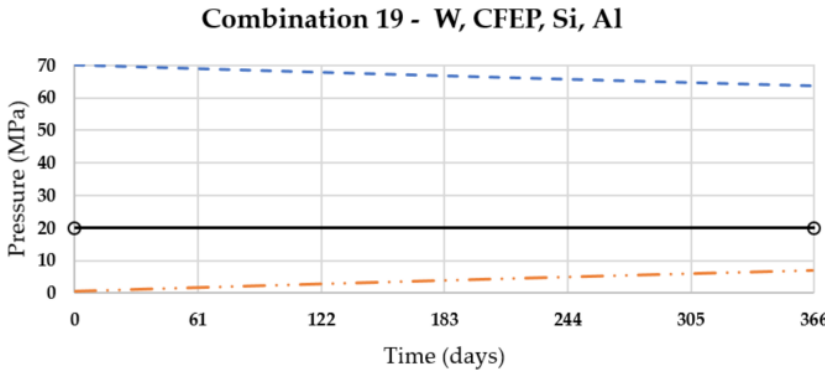
Figure 4. Pressure inside of the spheres and the envelope tank, combination 7 from Table 3.